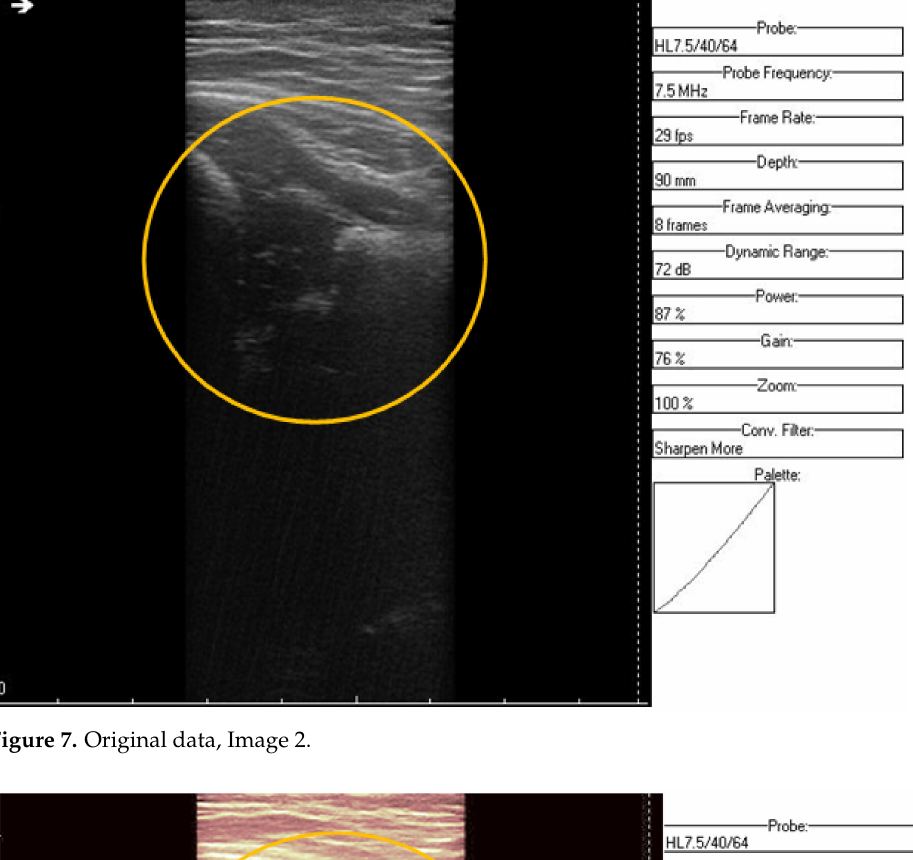
Figure 7. Original data, Image 2.